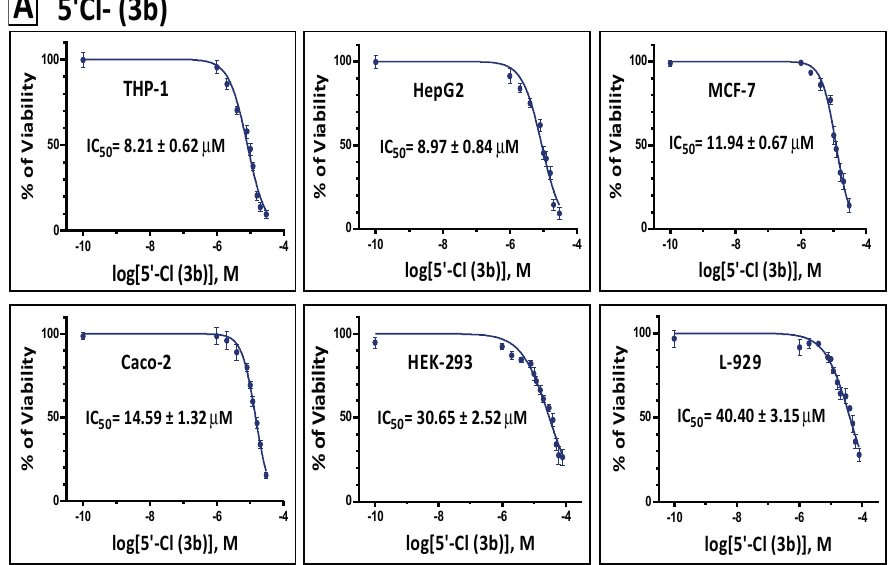
Figure 4. Compounds 3b and 3d inhibit the growth of various hematological and solid tumor cell lines but not noncancerous cells at low IC compounds 3b ( A ) and 3d ( B ) were determined for cultured cancer cells THP-1, HepG2, MCF-7 and Caco-2 and noncancerous HEK-293 and L-929 after incubation for 48 h with varying concentrations of the test compound as described in Figure 2 using the same GraphPad Prism 6